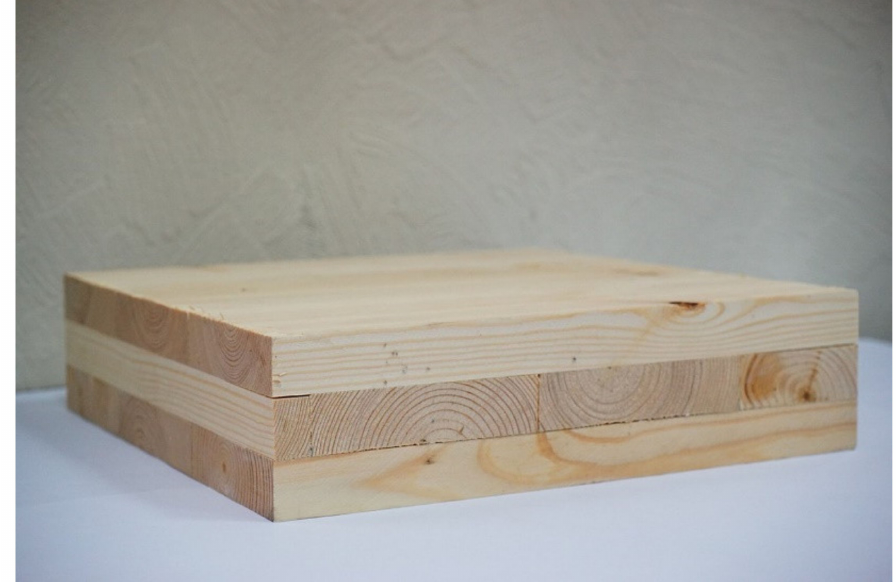
Figure 1. CLT (source: